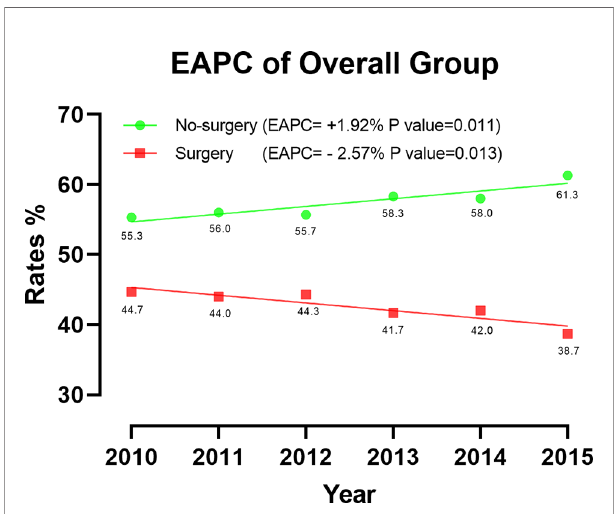
FIGURE 2 | Estimated annual changes (EAPC) of overall patients between